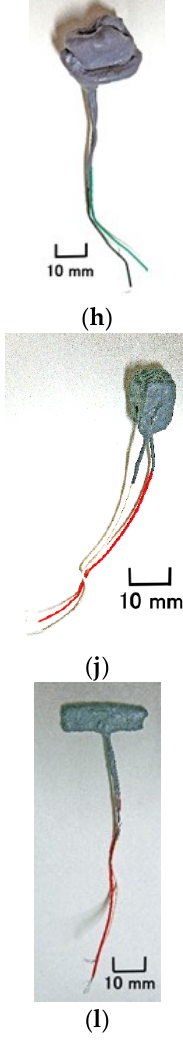
Figure 11. Photographs of the consummated fabric of each cutaneous receptor produced by electrolytic polymerization with HF: ( a ) consummated fabric at Phase 2 in Figure 4; ( b ) consummated fabric at Phase 4-1 in Figure 6; ( c ) consummated fabric at Phase 4-2 in Figure 6; ( d ) consummated fabric of ( b ) to be bundled, immersed and dried during Phase 4-2 in Figure 6; ( e ) consummated fabric at Phase 3 in Figure 5; ( f ) fabric electrolytically polymerized during Phase 5-1 in Figure 7; ( g ) consummated fabric to be coiled during Phase 5-1 in Figure 7; ( h ) consummated fabric at Phase 5-2 in Figure 7; ( i ) consummated fabric at Phase 6-1 in Figure 8; ( j ) consummated fabric at Phase 6-2 in Figure 8; ( k ) consummated fabric at Phase 7-1 in Figure 9; ( l ) consummated fabric at Phase 7-2 in Figure 9.